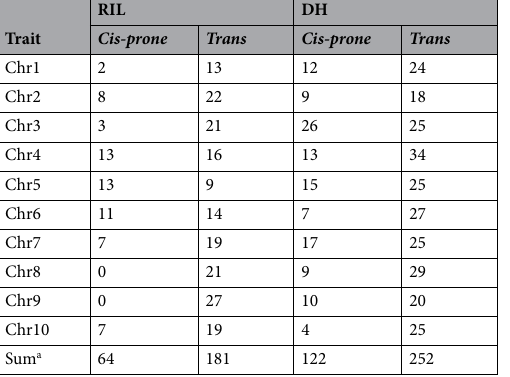
Table 1. Summary of cis - and trans - QTL mapping results in 11 RIL and 23 DH populations. a is the total number of QTL for each type ( cis-prone , trans ) across the ten